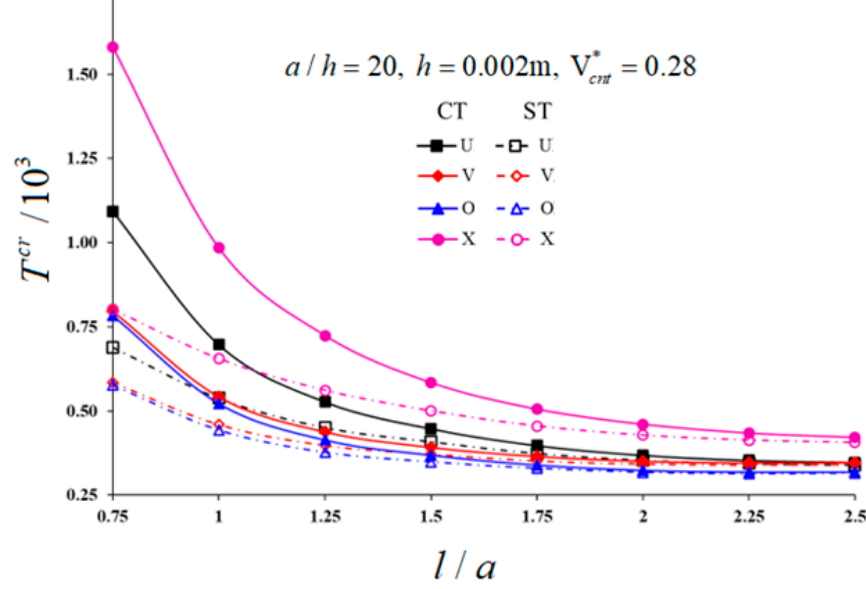
Figure 4. Variation of CUT against the l / a ratio within ST and CT.